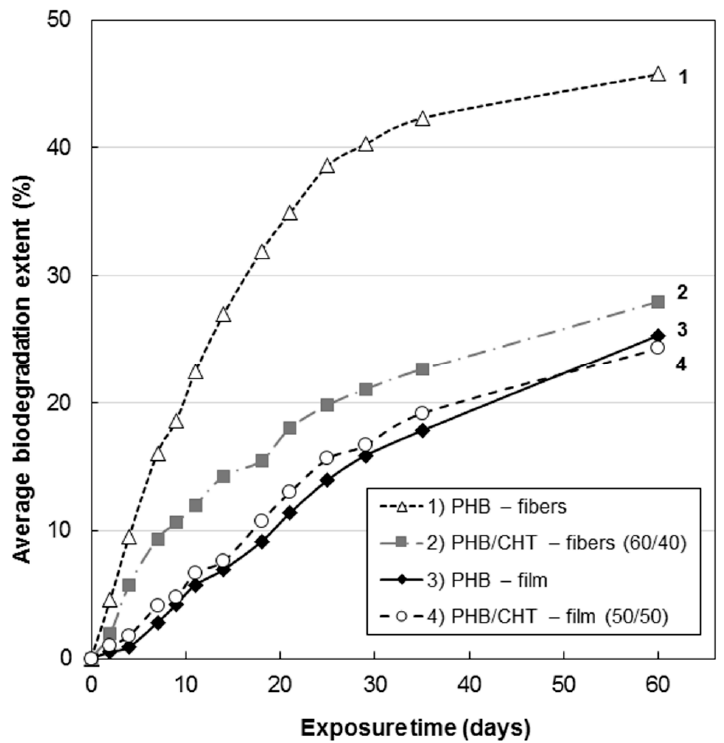
Figure 2. Kinetics of biodegradation (according to the Sturm method) of samples of nonwoven fibrous and film materials: ( 1 ) PHB—fibers; ( 3 ) PHB—film; ( 2 ) PHB/CHT—fibers (60/40); and ( 4 ) PHB/CHT—film (50/50).